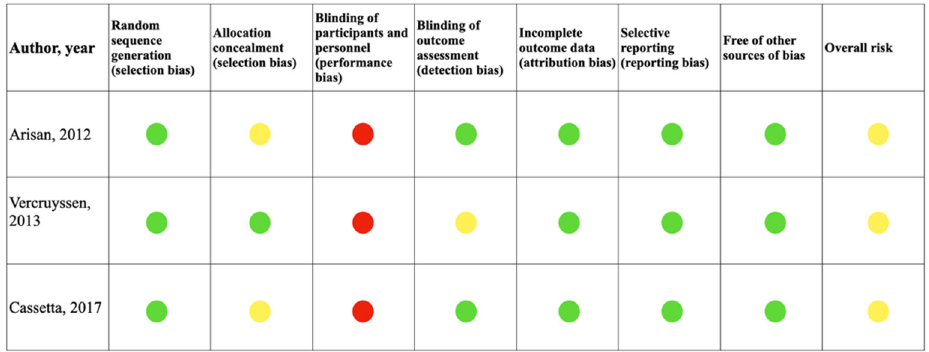
Figure 3. Quality assessment of the included studies following the Cochrane Collaboration’s tool 2 for assessing risk of bias in randomized trials (green, low risk; yellow, unclear risk; red, high risk).